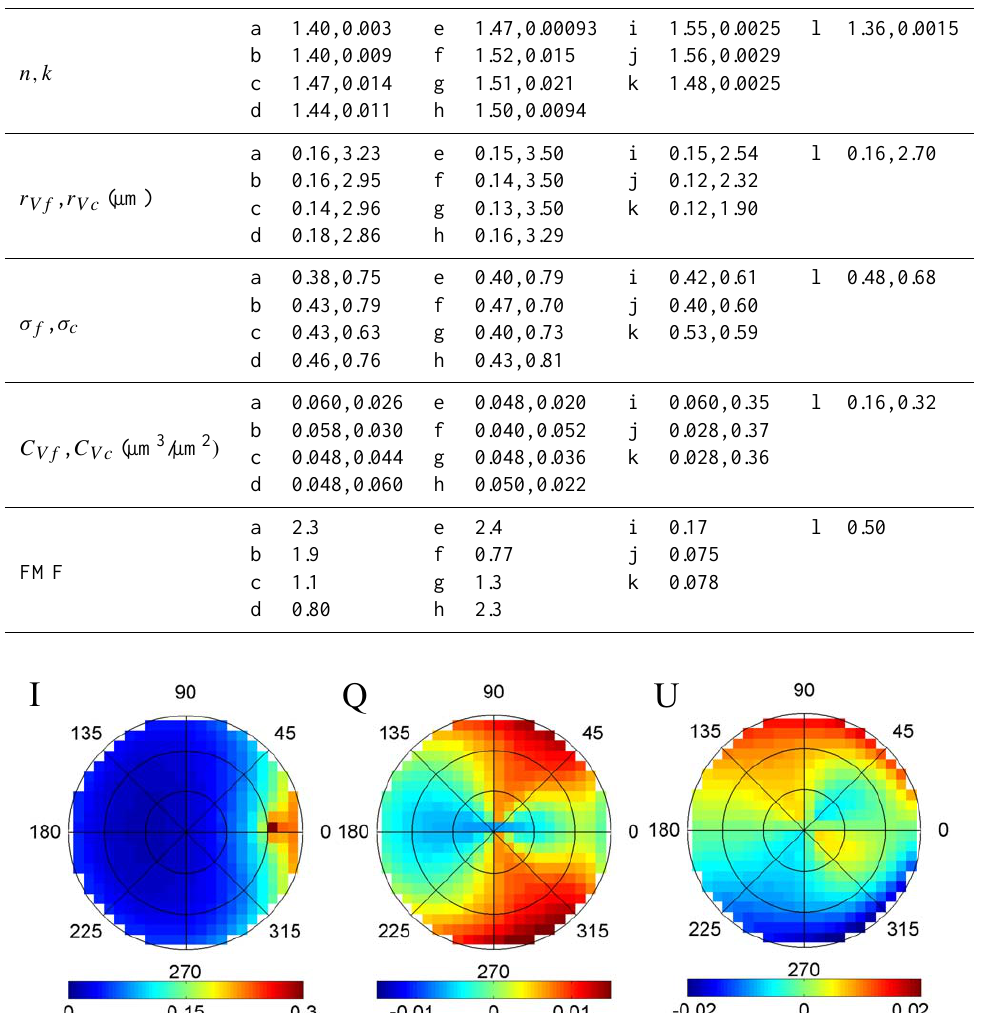
Fig. 1. Polar plots of the Stokes maps I , Q and U from model calculations for 650nm, SZA = 60 ◦ and urban aerosol type a (Greenbelt, USA) with AOD = 0.23. Azimuth angles are shown, while the zenith angles are indicated as concentric circles of 30, 60 and 85 ◦ , respectively. The radiance values are normalized to the extraterrestrial